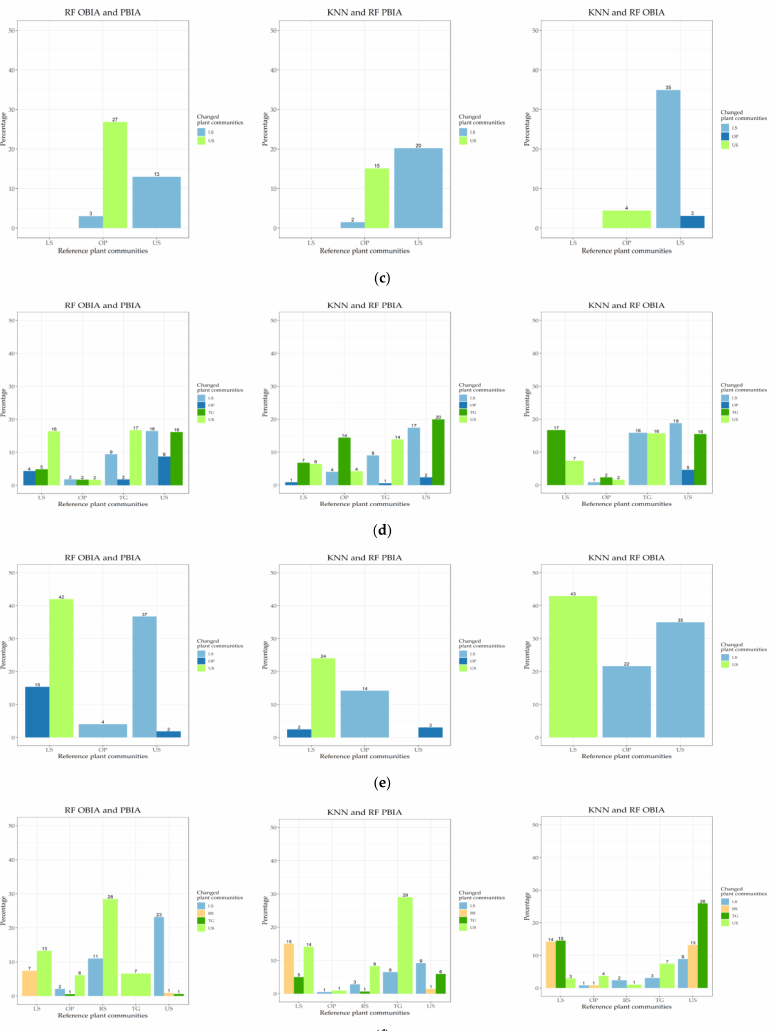
Figure A3. Percentage of area in each category ( x -axis) which has changed to another category ( y -axis). ( a ) Kudani, ( b ) Ralby, ( c ) Rumpo East, ( d ) Tahu South, ( e ) Tahu North and ( f ) Matsalu02. From left to right: changes in RF in OBIA and PBIA classification; changes in KNN and RF in PBIA classification; and changes in KNN and RF in OBIA